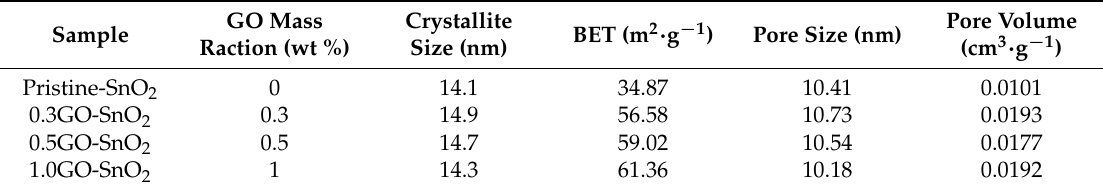
Table 2. Material data analysis of GO-SnO 2 with different mass fraction